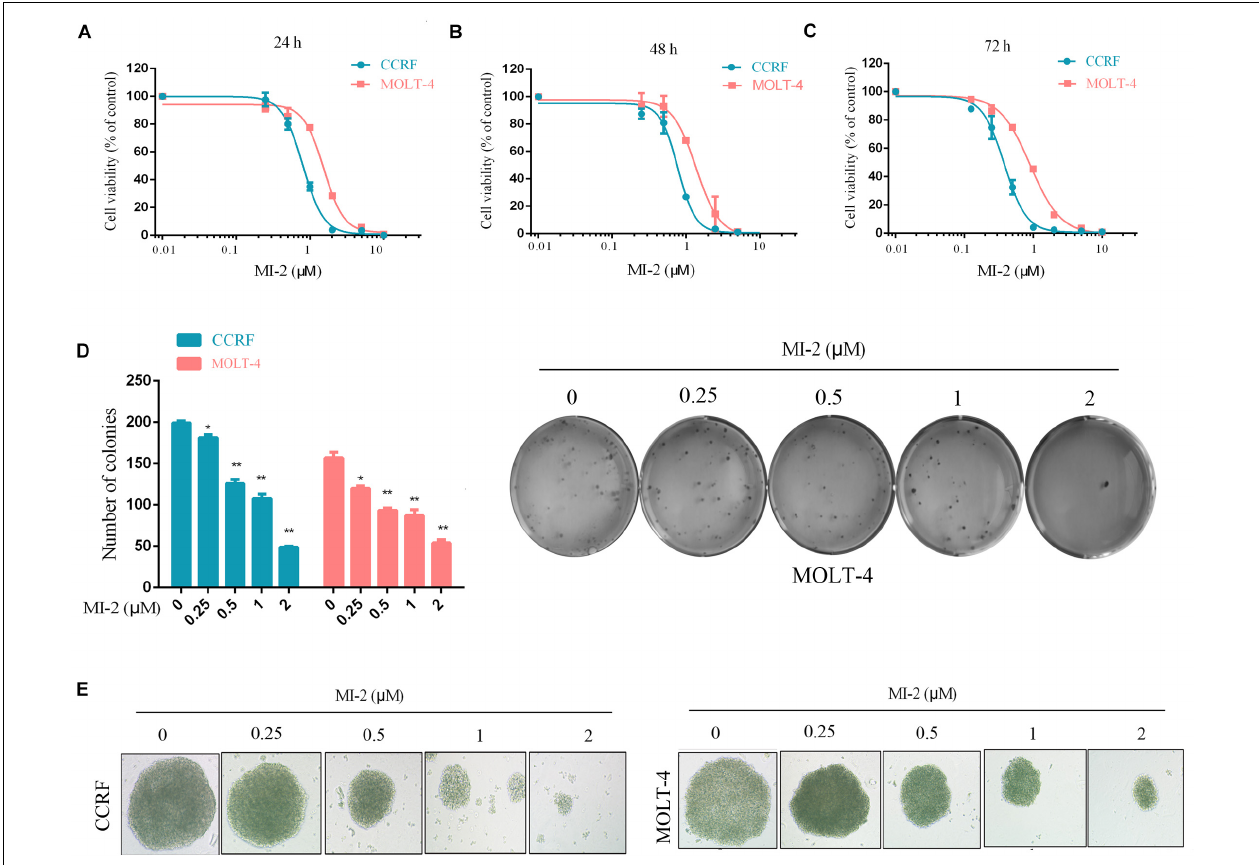
FIGURE 1 | MI-2 inhibited the growth of T-ALL cells. (A–C) CCRF and MOLT-4 were incubated with increasing concentrations of MI-2 for 24, 48, and 72 h, respectively. Cell viability was quantified using CCK-8 assay and shown as% of the untreated control. (D,E) CCRF and MOLT-4 were cultured in methylcellulose with indicated doses of MI-2 for 12 days. MI-2 significantly decreased the quantity and size of cell colonies. * P < 0.05, ** P <